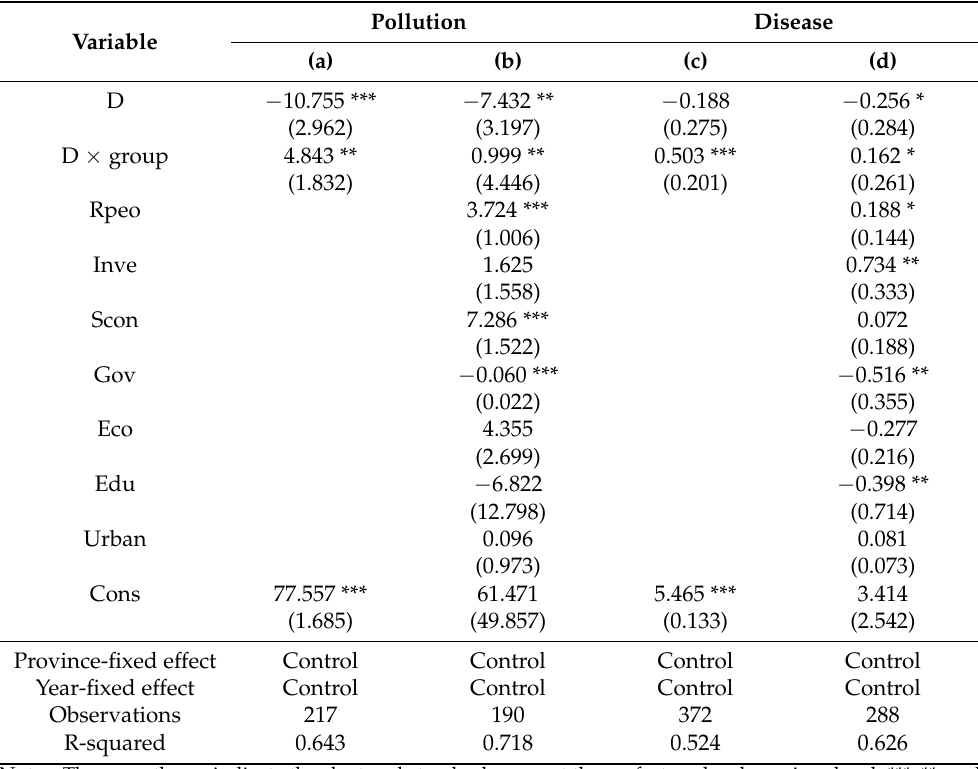
Table 5. Heterogeneity analysis.